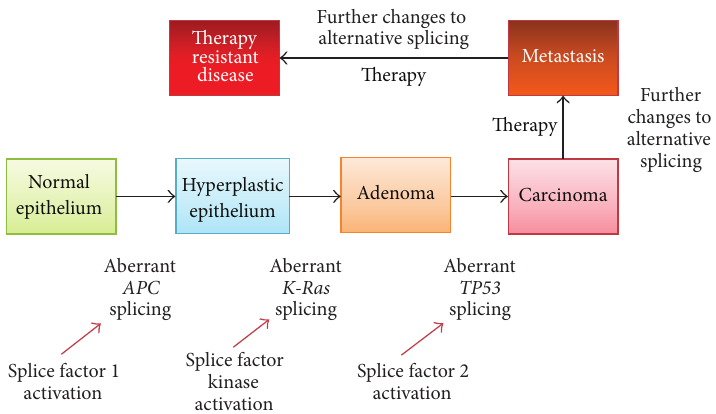
Figure 2: The adenoma-carcinoma sequence classically illustrates the multistage aetiology of colorectal cancer. Three genes frequently involved are APC , K-Ras , and TP53 . This theoretical model suggests that the genetic lesions that drive the stages include changes that cause the inappropriate activity of oncogenic splice factors or splice factor kinases. The result is a significant change in the ratio of splice isoforms that drastically alter APC , TP53 , and K-Ras function. Conventional treatments might cause selective pressures that drive further changes in the alternative splicing of key genes, leading to resistance to